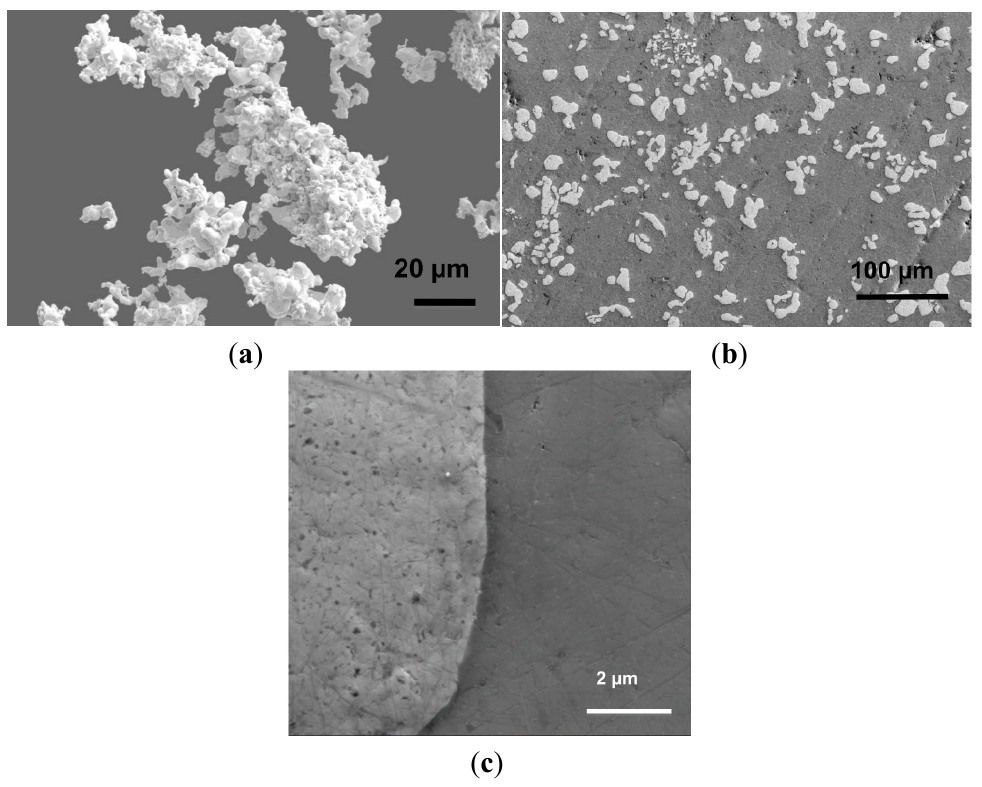
Figure 1. ( a ) SEM image showing the morphology of Ta particles. ( b ) SEM backscattered electron image showing a uniform dispersion of Ta particles in a La matrix. ( c ) A higher magnification image showing the interface between Ta and the glassy matrix, which seems to be devoid of reaction products.